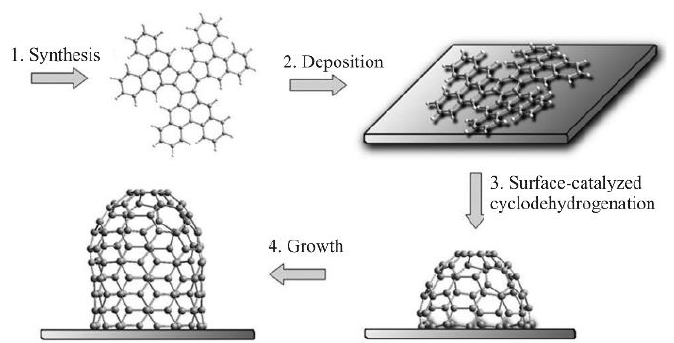
Figure 11. General scheme for the cyclodehydrogenation of the end-cap precursor and the subsequent growth of the CNT [69]. Copyright 2010, with permission from Elsevier.